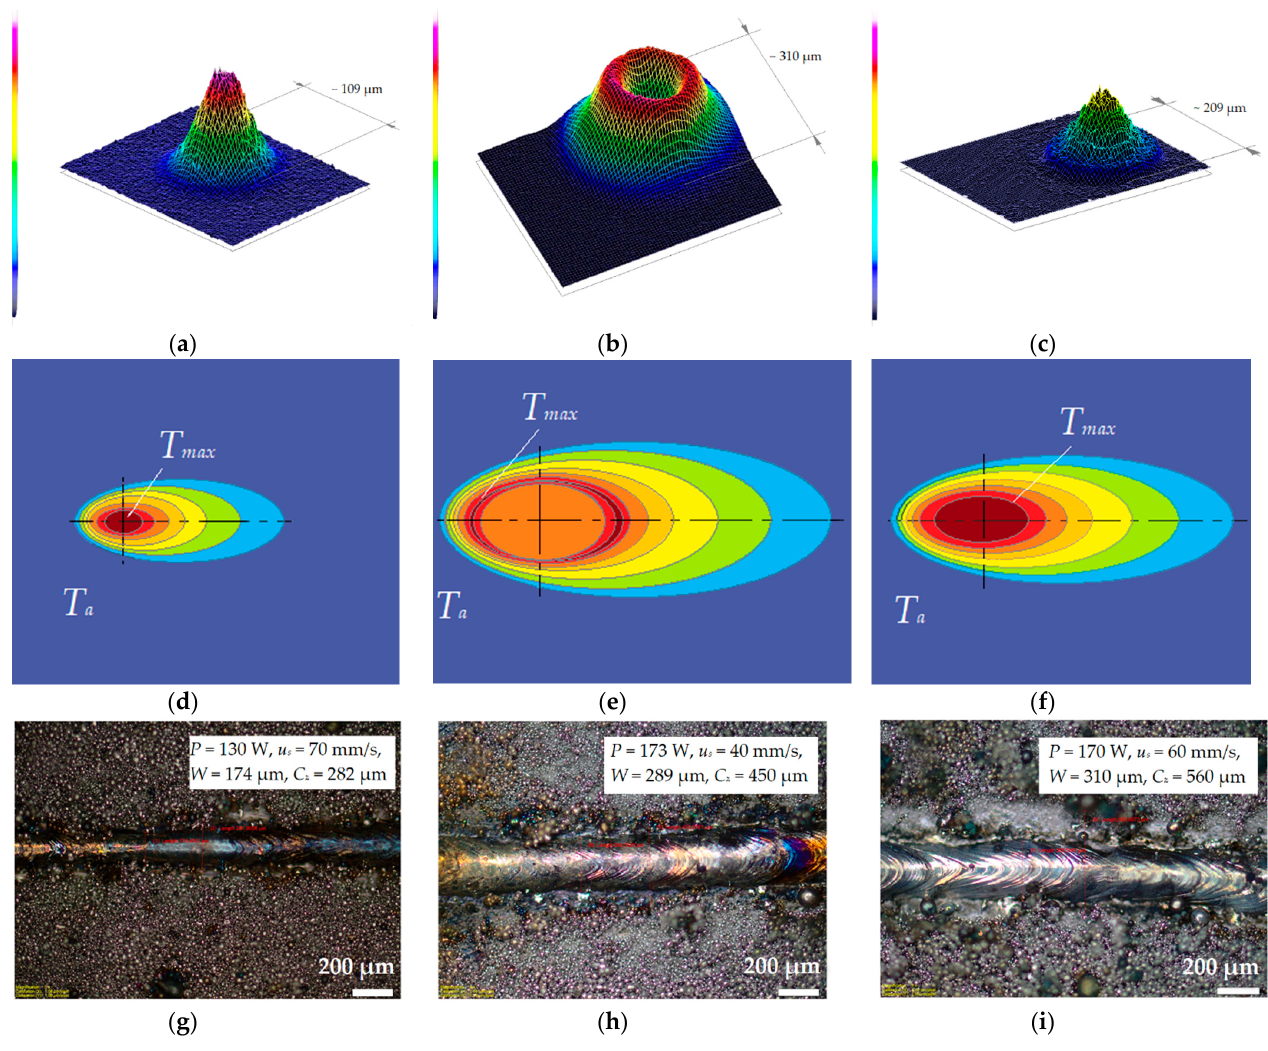
Figure 11. Melt pool formation: ( a ) torch-like; ( b ) torch-like with an increase of energy in the laser beam; ( c ) more uniform surface-like with an increase of redistributed energy in the melt pool.